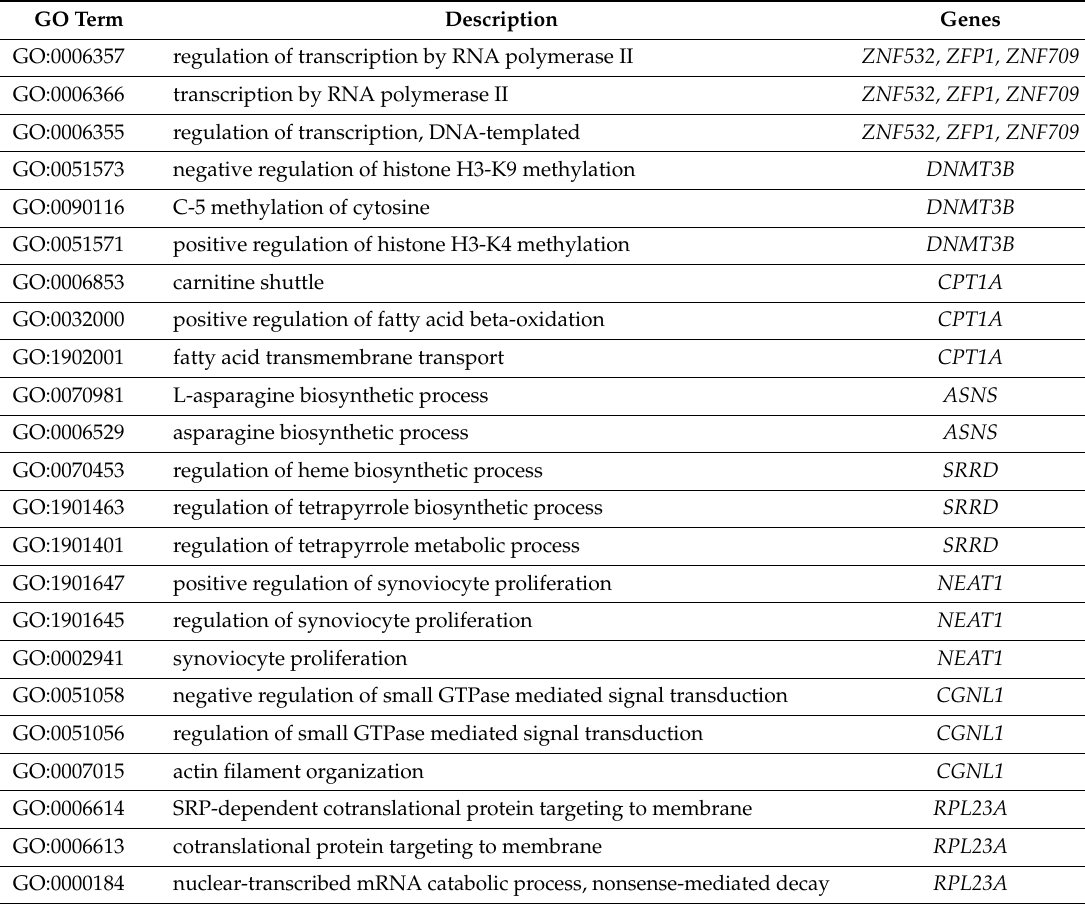
Table 4. Metascape functional annotation clusters for upregulated genes in embryos treated with FeEVs compared to control.